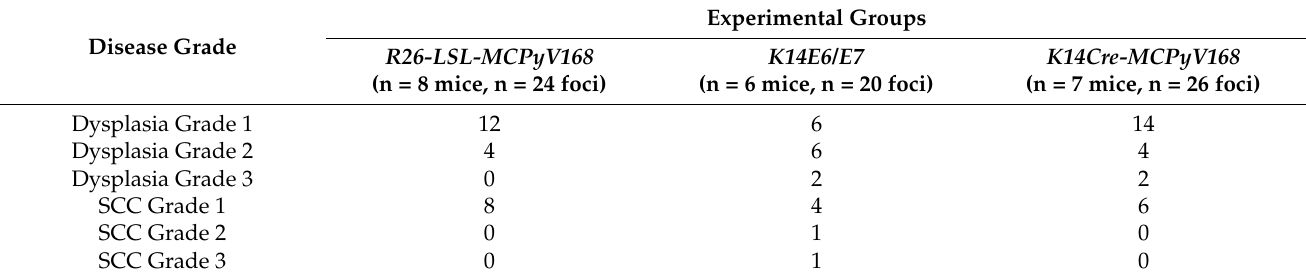
Table 2. Histopathological scoring of disease in tumors arising on murine skin after treatment with chemical carcinogens. After completing 20 weeks of TPA treatment following one-time treatment with DMBA, mice were held for an additional 5 weeks to monitor malignant progression. The number of mice and total tumors/foci evaluated is indicated in parentheses. The number of foci scored as having each disease grade is indicated for each group of